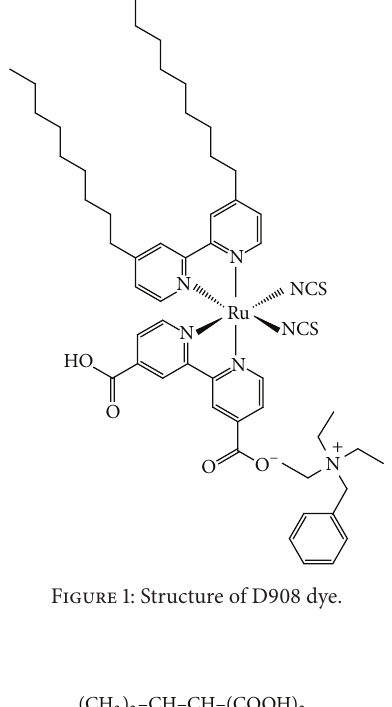
Figure 1: Structure of D908 dye.